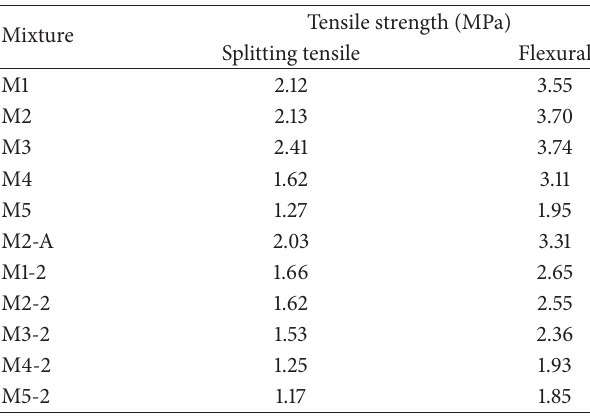
Table 6: Tensile strength of OPSGC. Tensile strength (MPa) Mixture Splitting tensile